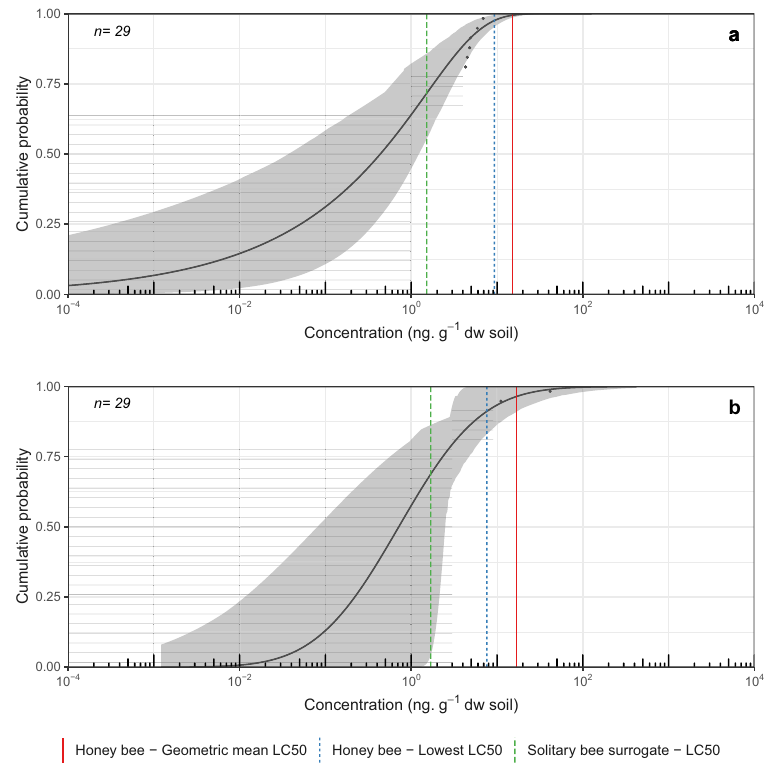
Figure 2. Environmental Exposure Distribution (EED) for acute exposure to ( a ) clothianidin and ( b ) imidacloprid concentrations measured in soil samples taken from 0–15 cm depth in Cucurbita -crop fields in Ontario, 2016. Effects benchmark concentrations for acute exposure (48 h, 2.23 g soil) for the hoary squash bee, Peponapis pruinosa (i.e. honey bee geometric mean LC 50 = red vertical line, honey bee lowest LC 50 = blue vertical dotted line, and the solitary bee surrogate LC 50 = green vertical dashed line), are represented on the EED. Exceedance of these endpoints is calculated by subtracting the cumulative probability from one. Grey horizontal lines represent individual soil samples below the analytical limits of detection or quantification, and black dots indicate samples for which insecticide residues could be quantified. The black line indicates the line of best fit to the data via maximum likelihood estimation (MLE) with associated 95% confidence intervals (grey